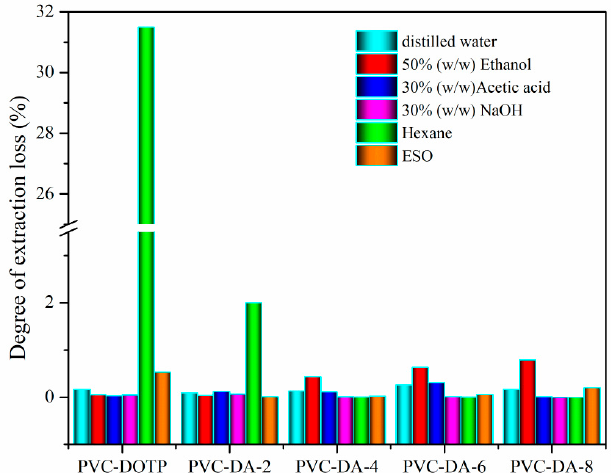
Figure 10. Degrees of extraction loss of PVC-DA-2n (2n = 2, 4, 6, and 8) and PVC-DOTP at 25 ◦ C for 24 h.